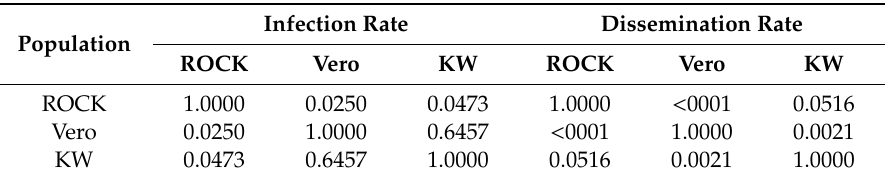
Table 2. Pearson Chi-square p -value on pairs for CHIKV infection and dissemination rate at ten days post-exposure to chikungunya virus.